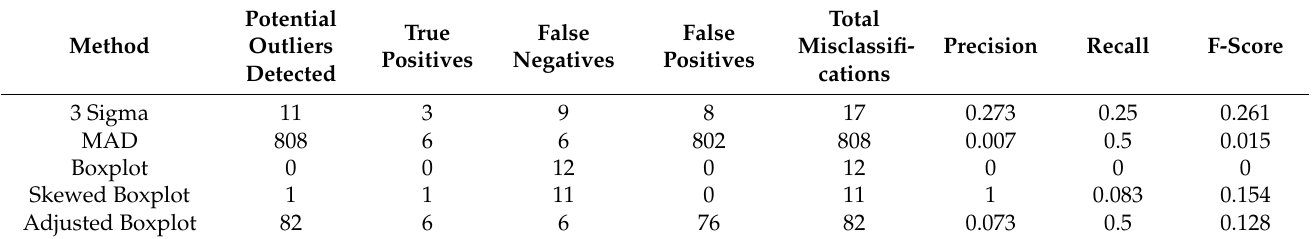
Table 3. Number of outliers found in the global search by each method on adapted